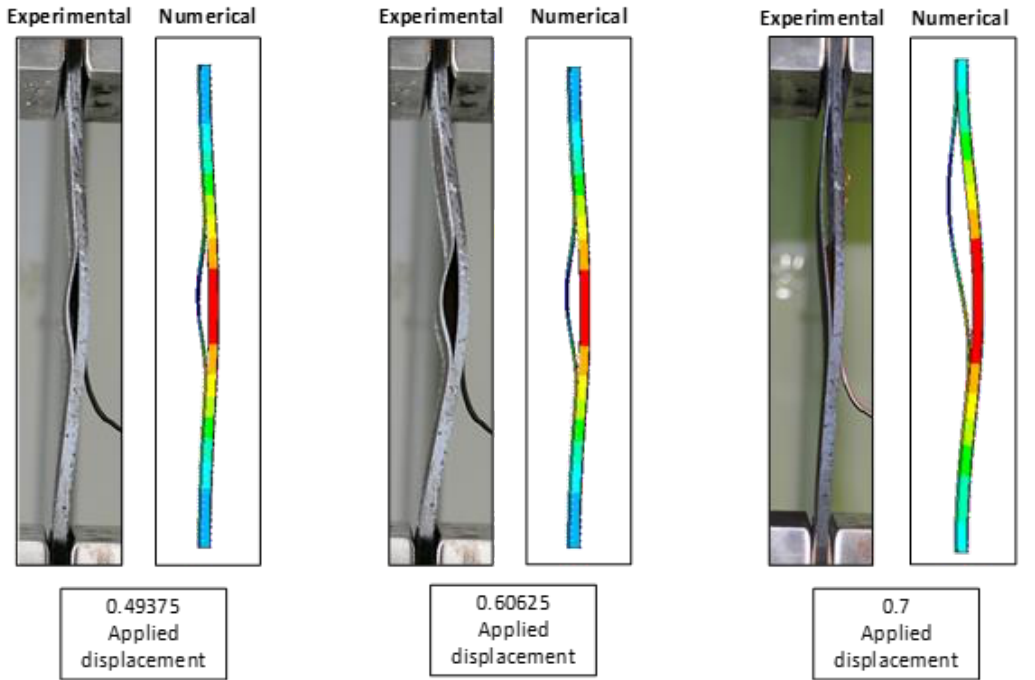
Figure 23. Numerical and experimental deformed shape comparison. Material sensitive to fibre bridging.